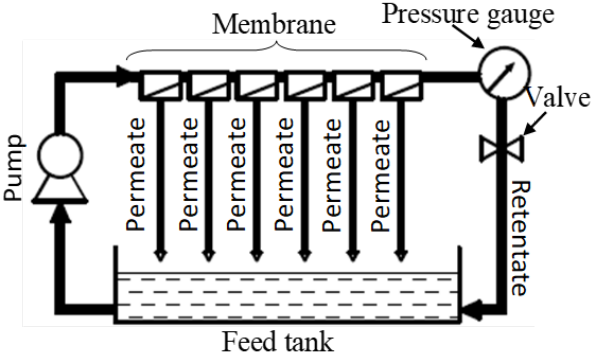
Figure 1. Schema of “Lab Module Type 20” plate and frame system.